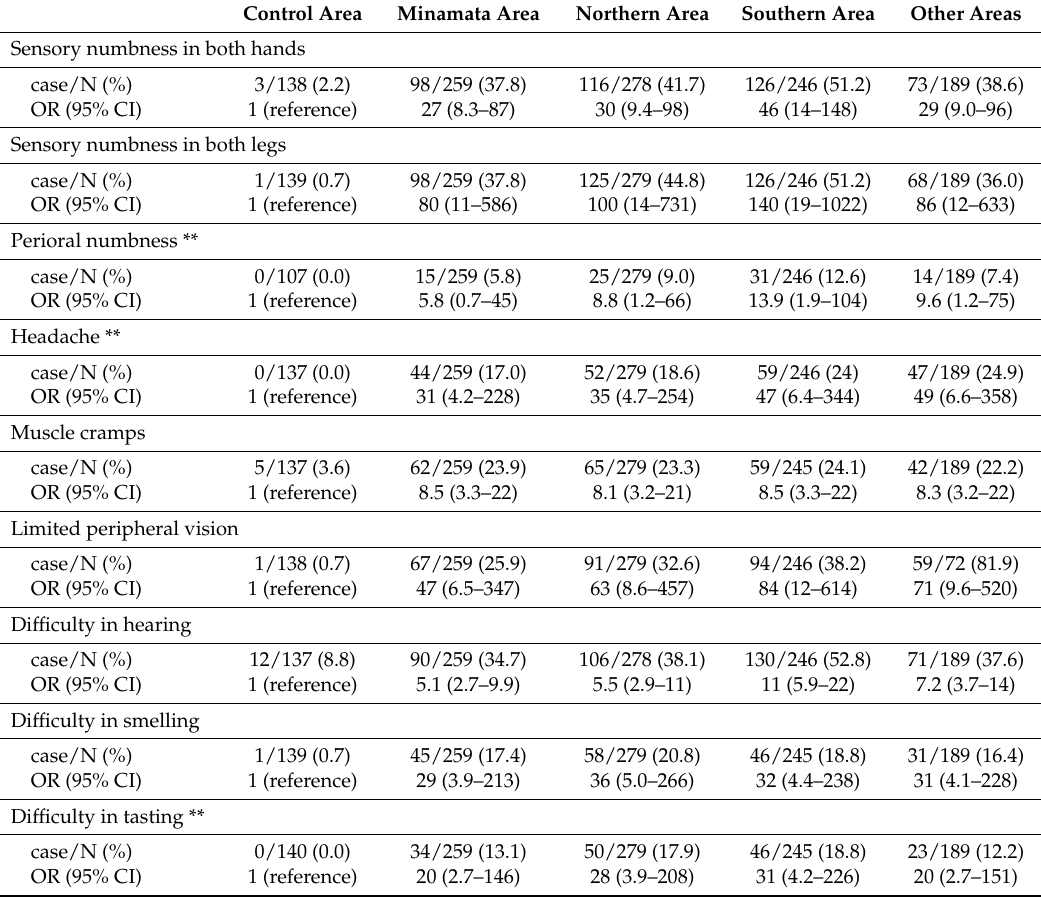
Table 3. Prevalence of symptoms (Always) and adjusted * odds ratios (OR) for the association between area and symptoms ( n =